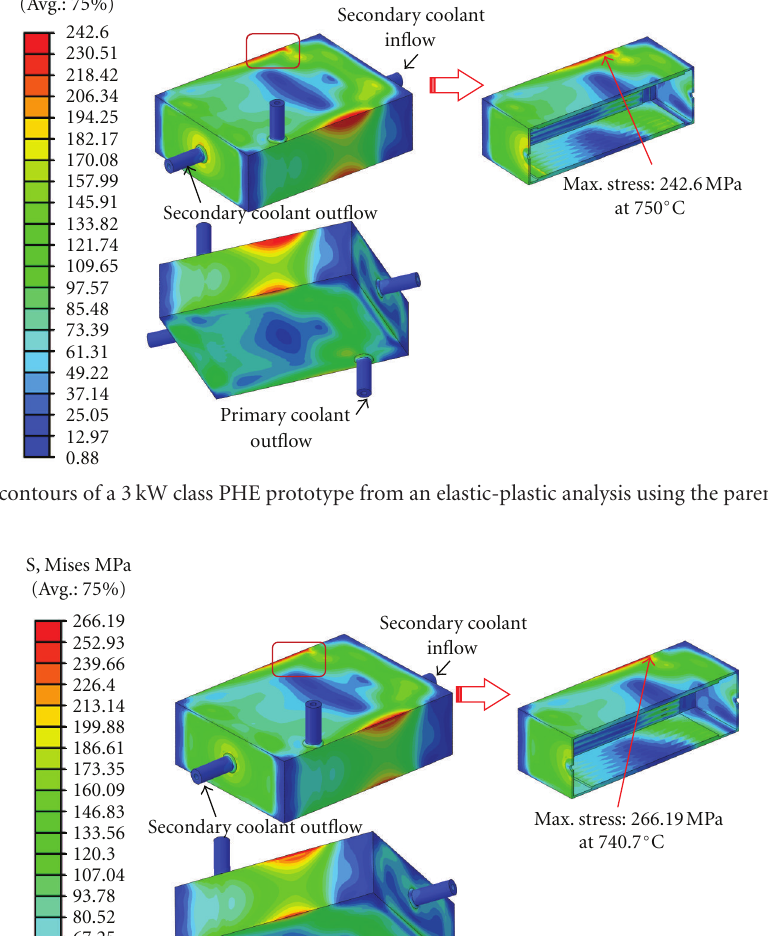
Max. stress: 266.19 MPa at 740.7 ◦